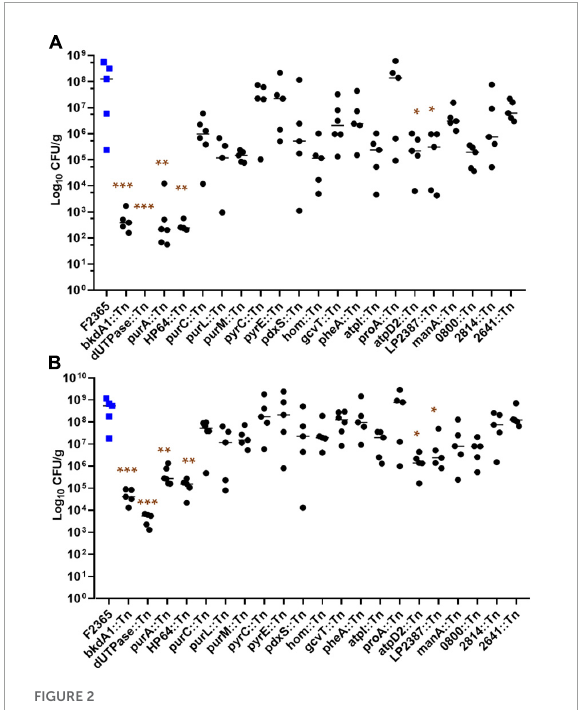
FIGURE2 Virulence phenotypes of L. monocytogenes Tn-insertion mutants. Each animal group (5 mice per cage) was intravenously infected with 2 × 10 4 colony forming units (CFUs) with the indicated strains. At 72 h post-infection, bacterial concentrations were determined for livers (A) and spleens (B) . Each point represents one mouse. Statistical analysis was performed with Kruskal-Wallis test in GraphPad Prism. *Indicates a significant difference at P < 0.05, **indicates a significant difference at P < 0.001, and ***indicates a significant difference at P <